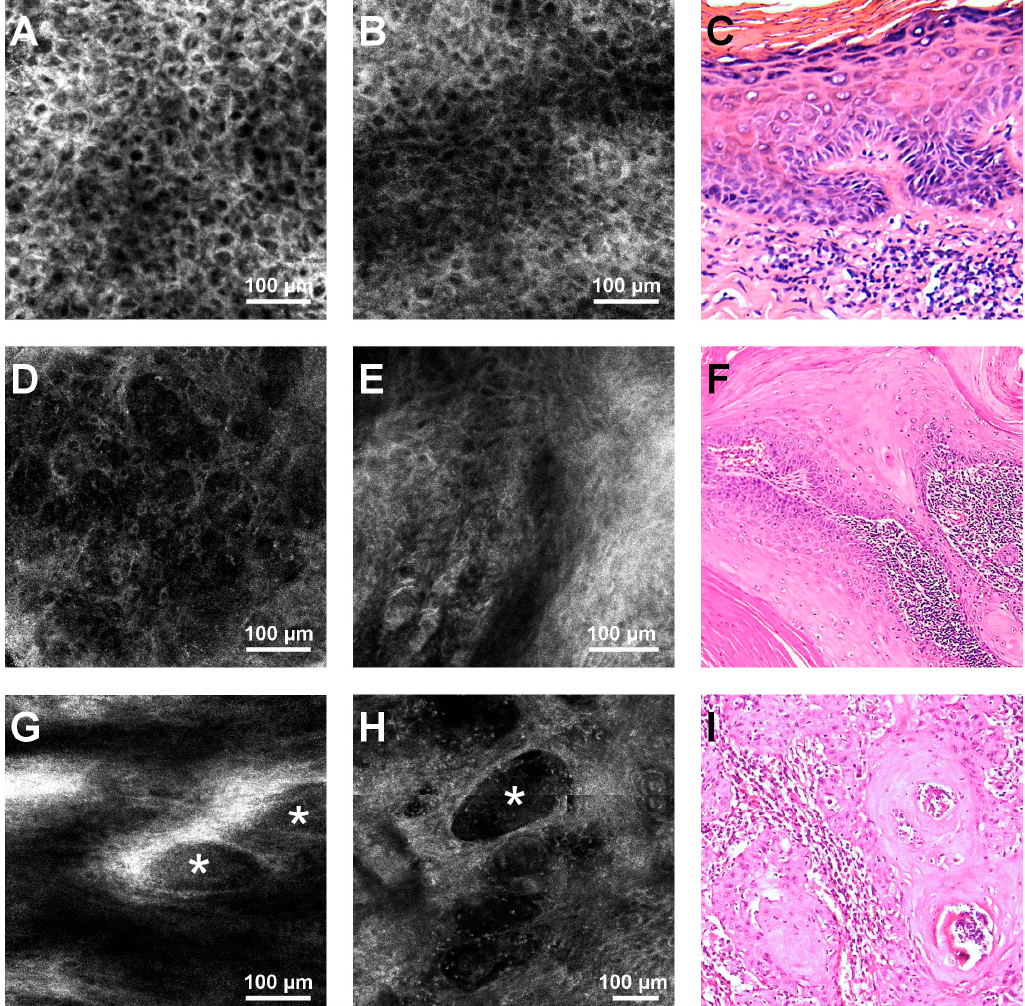
Figure 1. Representative reflectance confocal microscopy (RCM) images of actinic cheilitis (AC) and lip squamous cell carcinoma (SCC), and histological correspondents. ( A ) RCM image of an atypical honeycomb pattern of the stratum granulosum, seen in an AC lesion. ( B ) RCM image at the stratum spinosum showing an atypical honeycomb pattern, which can be seen in either AC or SCC. ( C ) Histopathology image illustrating parakeratosis, atypical keratinocytes in the stratum granulosum and spinosum, spongiosis, and intradermal inflammatory infiltrate in an AC lesion (haematoxylin-eosin, cropped, original magnification 40×). ( D ) RCM image of the complete architectural disarray in the granular layer of a lip SCC. ( E ) RCM image showing disarray in the stratum spinosum, in a SCC lesion. ( F ) Histopathological image displaying infiltrative atypical polygonal squamous cells with distinct cell borders, abundant eosinophilic cytoplasm, and large vesicular nuclei with moderate nuclear pleomorphism in a SCC (haematoxylin-eosin, cropped, original magnification 40 × ) ( G , H ). RCM images showing tumor nests (white asterisks) surrounded by white areas corresponding to fibrosis at the level of the dermis, in a SCC. ( I ) Histopathology image illustrating invasive SCC nests and strands of atypical polygonal squamous cells surrounded by intradermal inflammatory infiltrate in a lip SCC (haematoxylin–eosin, cropped, original magnification 100 ×